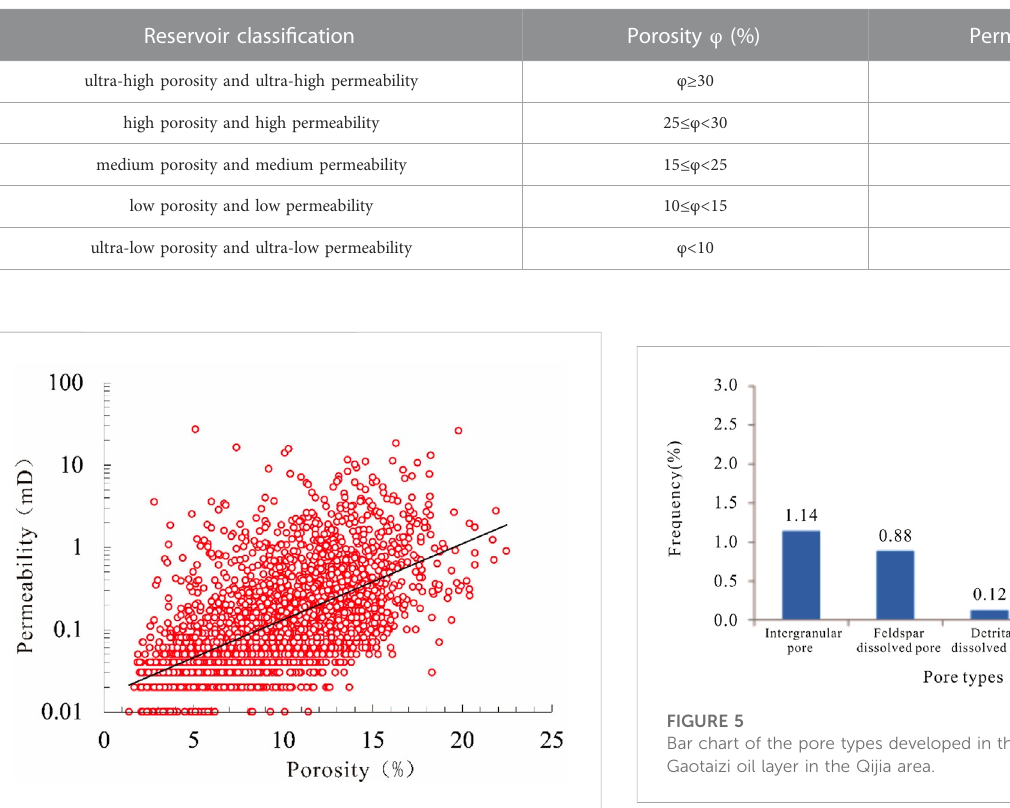
FIGURE 4 Relationship between the porosity and permeability of the Gaotaizi oil layer in the Qijia area.